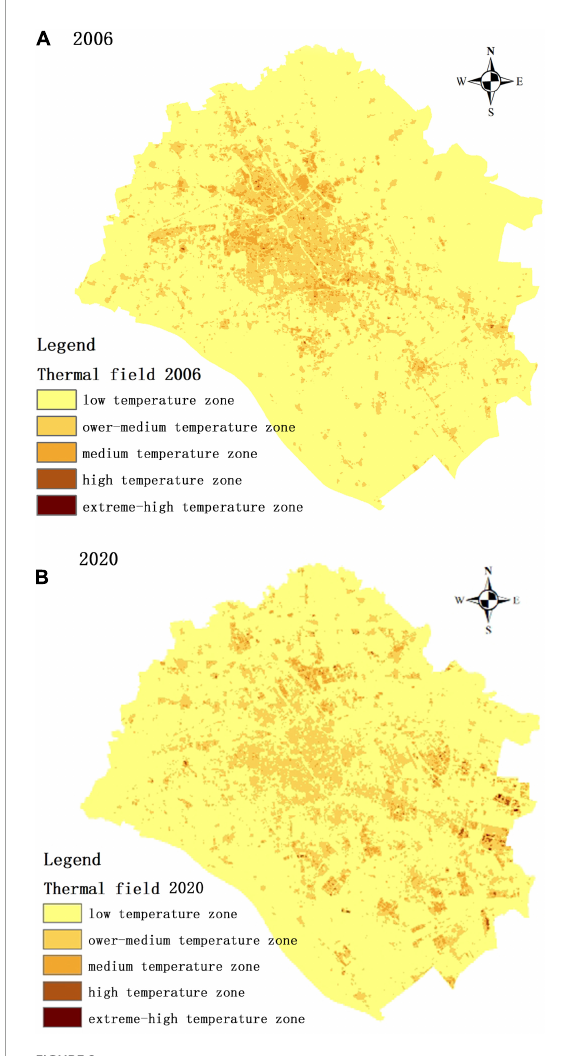
FIGURE2 Changes in thermal field distribution from (A) 2006 to (B) 2020.